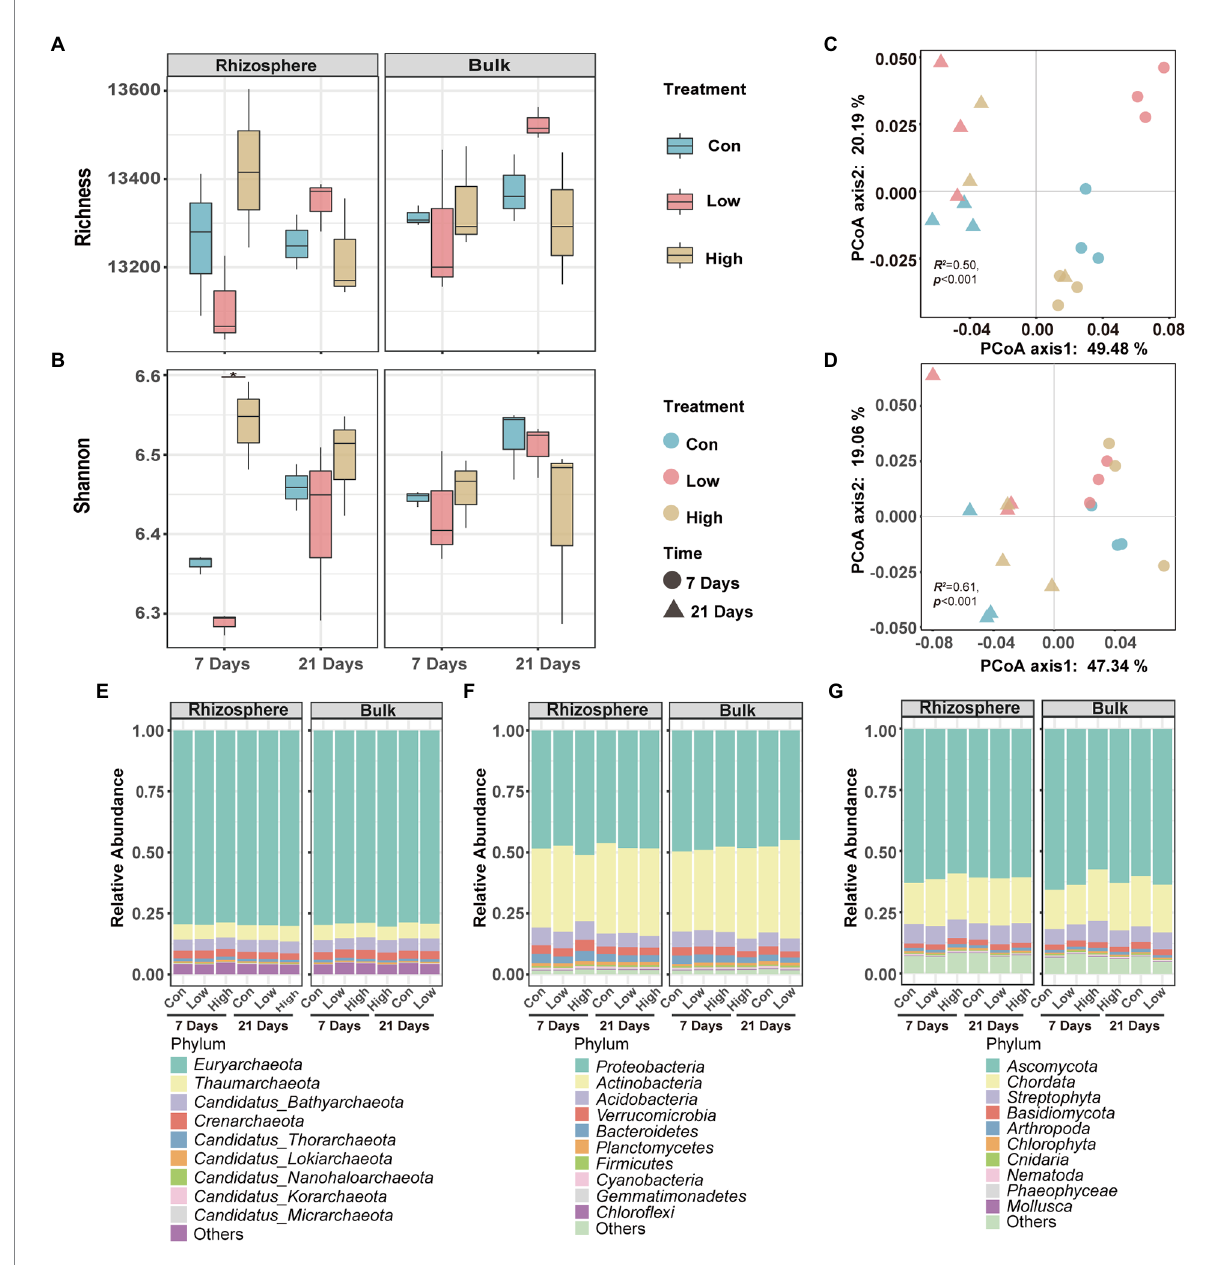
FIGURE 1 Effects of abamectin on diversity and structure of microbial communities. (A,B) Shannon index and richness calculated at the genus level. * Represents the significant differences between control and abamectin treatments (Kruskal–Wallis’s test, p < 0.05). (C,D) PCoA of Bray–Curtis dissimilarities of microbial communities at the genes level. Statistical significance was evaluated via PERMANOVA test. (E–G) Effects of abamectin on the community composition of the main phyla related with eukaryote, bacteria, and archaea,